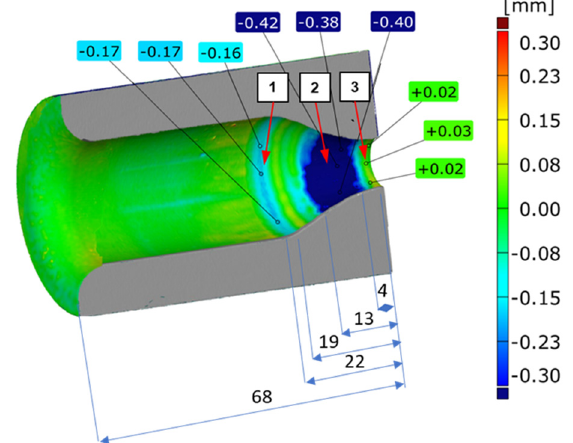
Figure 18. View of a scan results of the die after 2830 forgings with the characteristic zones (detailed analyzed and showed in Figure 13a with the lengths of: the die height and the individual zones are given in mm.